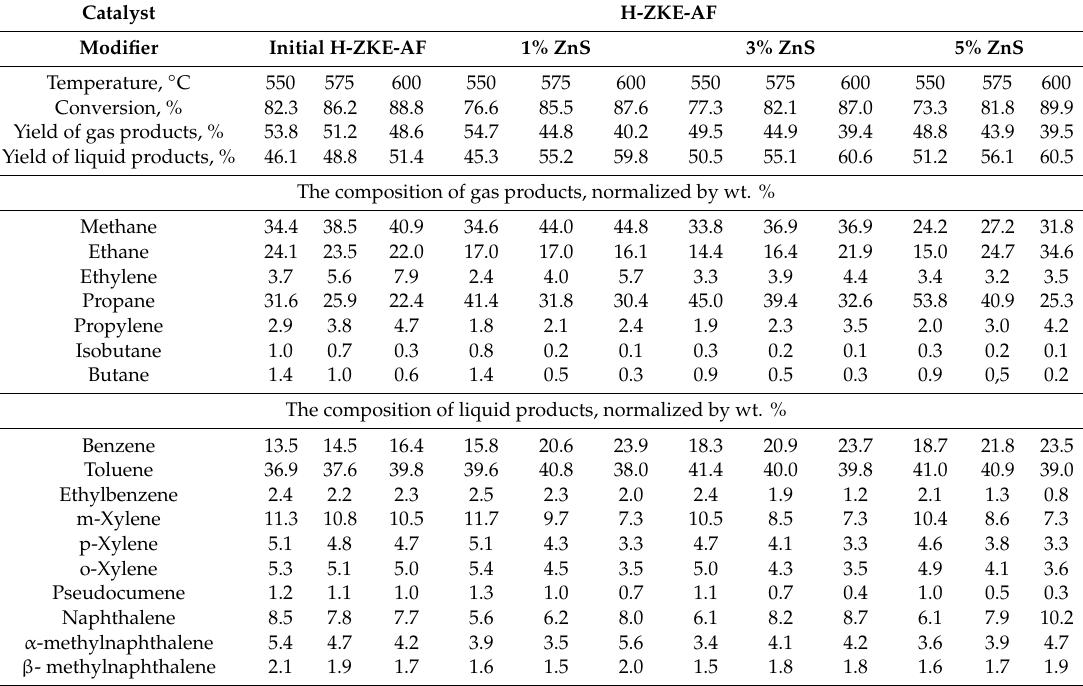
Table 2. E ff ect of temperature on product composition (wt. %) of PBF conversion process on H-ZKE-AF modified by 1–5% ZnS at a feed space velocity of 240 h − 1